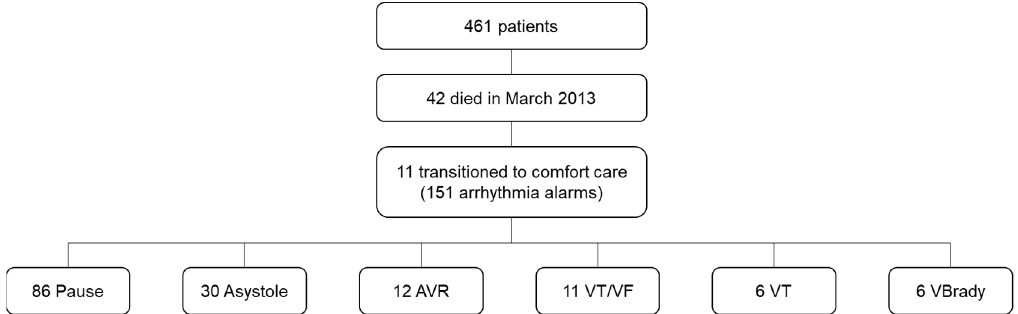
Figure 1. Frequencies of arrhythmia alarms during end of life care among 11 patients. Abbreviations: AVR = accelerated ventricular rhythm; VBrady = ventricular bradycardia; VT = ventricular tachycardia; and, VT/VF = ventricular tachycardia/ventricular fibrillation.